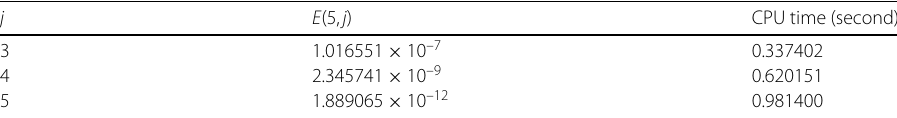
Table 5 Averaged square error of numerical solution and the required CPU time of approach II for λ = 1 and m = 5